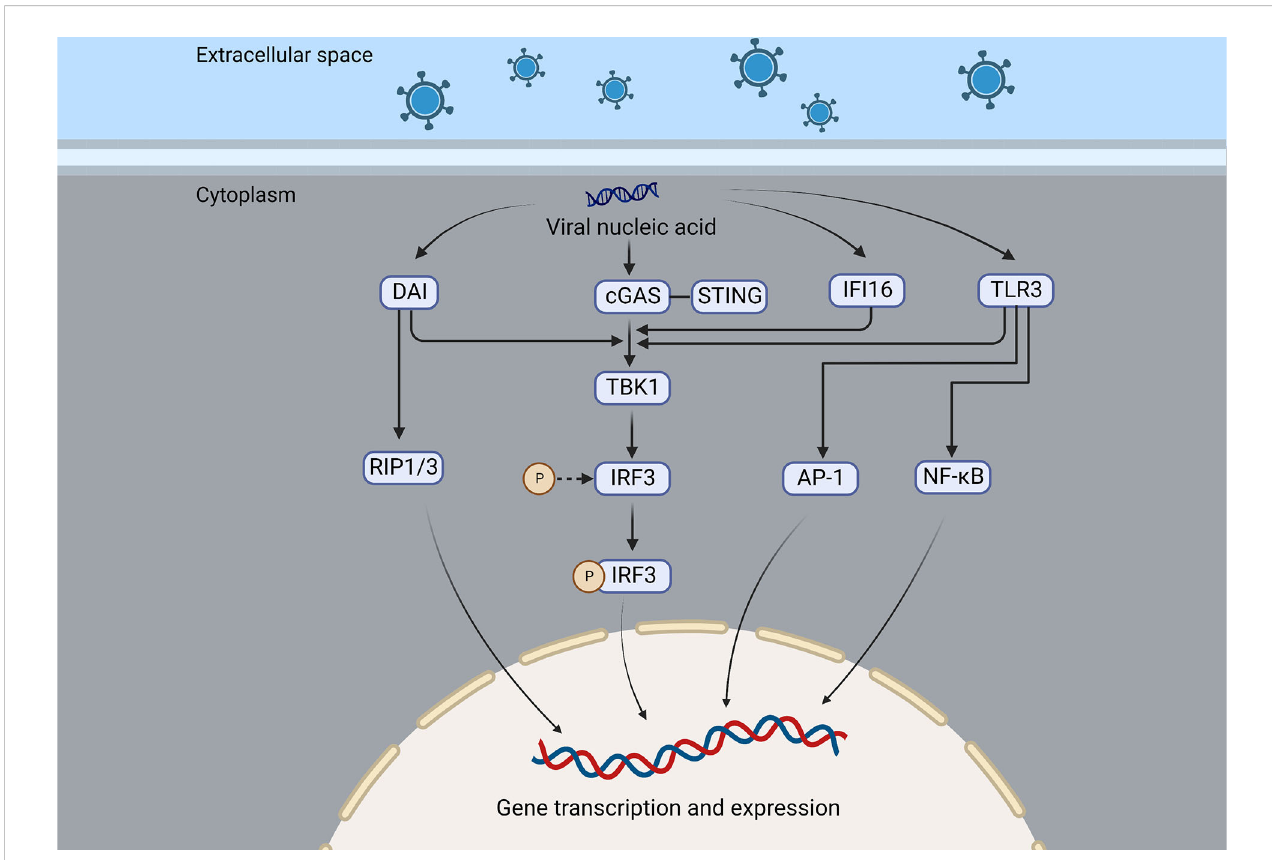
FIGURE 2 DAI, cGAS, IFI16, and TLR3 are nucleic acid sensing mechanisms of the virus that recruit and activate TBK1, which in turn activates IRF3, resulting in the expression of interferon or cytokines. In addition, DAI can also recruit RIP1/3 to promote gene transcription and expression, and TLR3 can activate NF- k B and AP-1 and induce the production of interferon and in fl ammatory